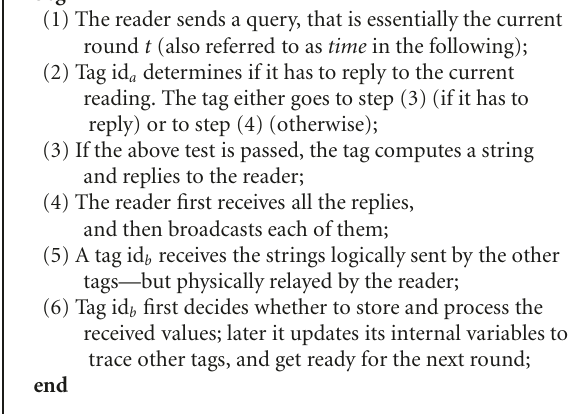
Algorithm 1: General behaviour of proposed